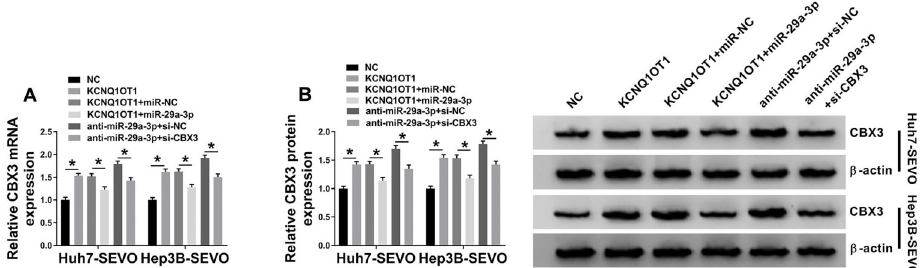
Figure 6. KCNQ1OT1 sponged miR-29a-3p to regulate CBX3 expression. Huh7 and Hep3B cells were treated with sevo fl urane (SEVO) for 48 h. A and B , The level of CBX3 was detected in Huh7-SEVO and Hep3B-SEVO cells transfected with negative control (NC), KCNQ1OT1, KCNQ1OT1 + miR-NC, KCNQ1OT1 + miR-29a-3p, anti-miR-29a-3p + si-NC, and anti-miR-29a-3p + si-CBX3 (n=3). Data are reported as means ± SD. *P o 0.05 (Student ’ s t -test or